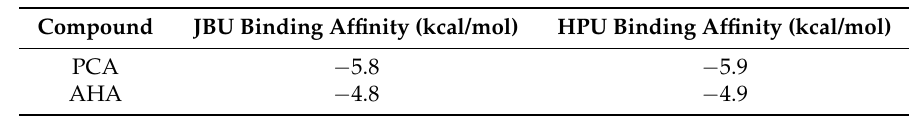
Table 1. Docking results of Jack bean urease (JBU; PDB code: 3LA4) and Helicobacter pylori urease (HPU; PDB code: 1E9Y) with protocatechuic acid (PCA) and acetohydroxamic acid (AHA; standard urease inhibitor).